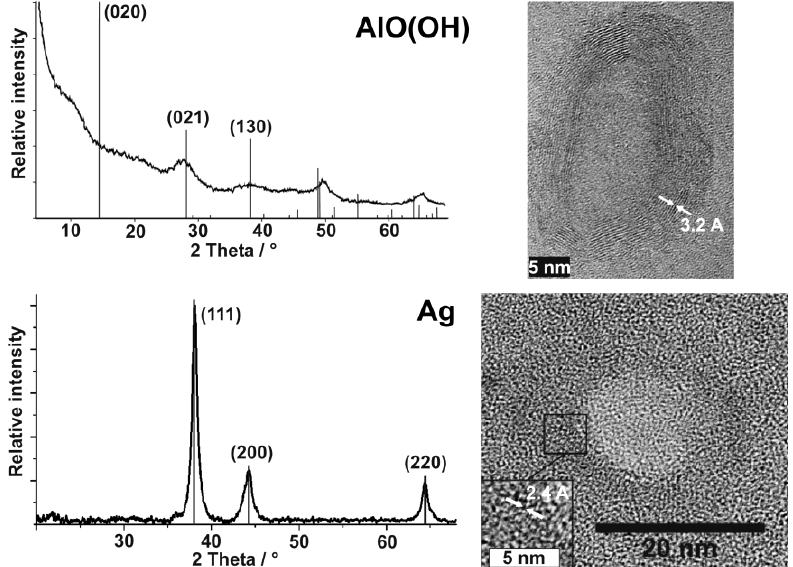
Figure 9. XRD and HRTEM of AlO(OH) and Ag hollow spheres showing crystallinity and composition of a manifold of particles as well as of selected single hollow spheres (modified reproduction from